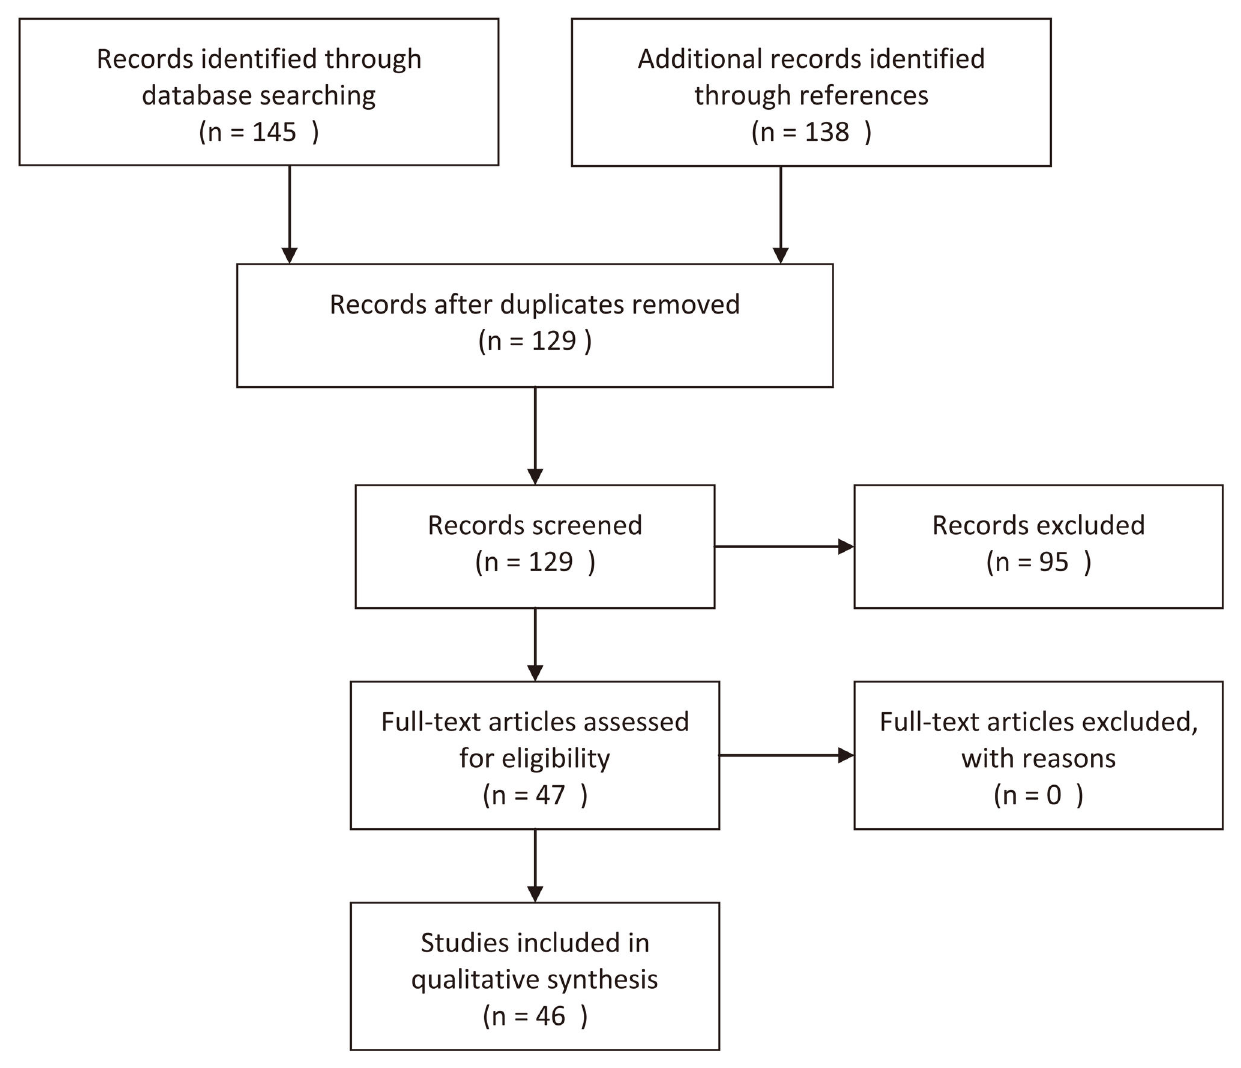
Figure 1. Flow chart of study